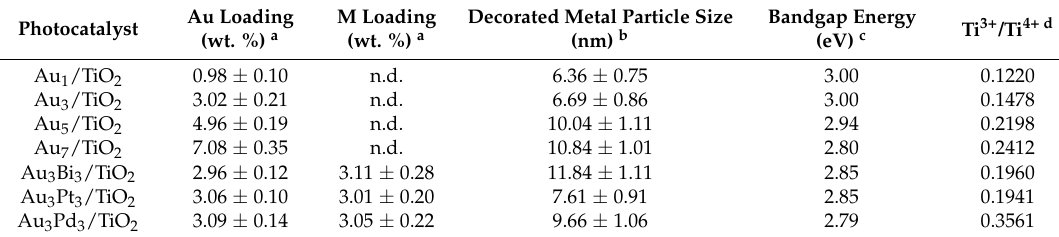
Table 1. Properties of the as-synthesized Au x /TiO 2 and Au 3 M 3 /TiO 2